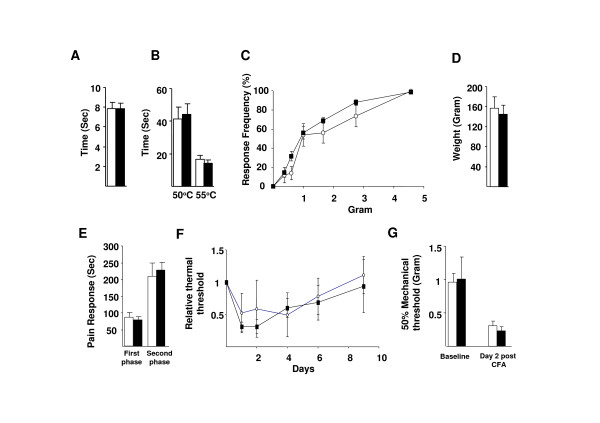
Acute and inflammatory pain behaviour in Nav1.3 KO is normal. Thermal threshold in the Hargreave's (A, WT 7.83 ± 0.7 sec, n = 8; KO 7.82 ± 0.6 sec, n = 11; P = 0.9) and hotplate apparatus (B, at 50°C WT 41.3 ± 7.3, n = 13; KO 44.2 ± 6.5, n = 13; P = 0.7. at 55°C WT 16.6 ± 2.4; KO 14.3 ± 1.8; P = 0.1) were similar. Mechanical threshold to range of von Frey hairs applied to hindpaw (C) and plunt force applied to tail (D, WT 157 ± 22.7 g, n = 13; KO 145 ± 18.2, n = 13; P = 0.4) were not different. Both phase of the formalin pain response were not different (E, phase 1 WT 86.1 ± 12.9 sec, n = 8; KO 78.4 ± 9.2, n = 8; P = 0.6. Phase 2 WT 210 ± 38.3 sec; KO 227.4 ± 24.2; P = 0.7). Injection of CFA in hindpaw elicited thermal (F) and mechanical hyperalgesia 2 days post injection (G, WT 0.3 ± 0.08 gram, n = 6; KO 0.23 ± 0.05, n = 6; P = 0.5) to the same level in both mice groups.